Question: Briefly state, in one sentence, what is plotted here.
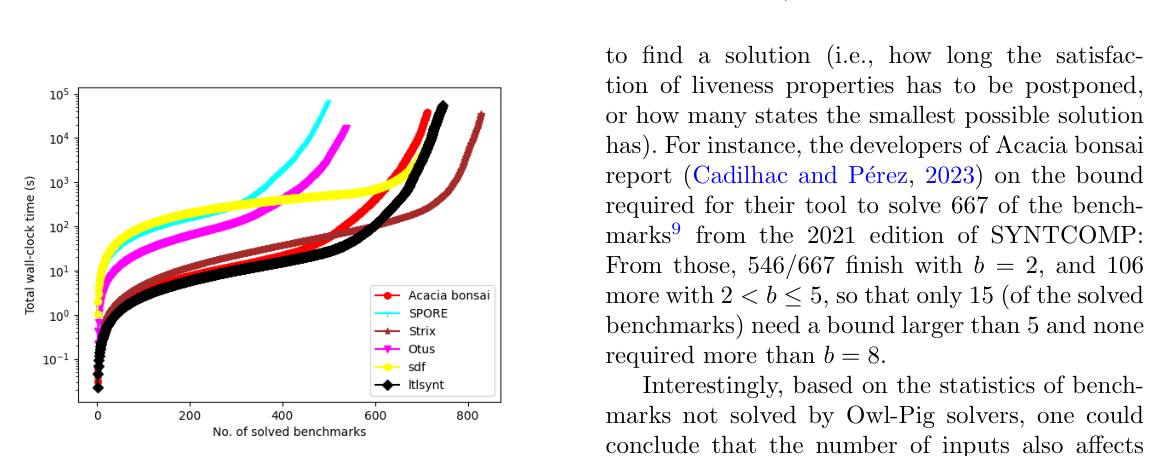
Answer: Cactus (a.k.a. survival) plots for the participants of the LTL realizability track of SYNTCOMP 2021; Note that the y-axis is displayed using logarithmic scale